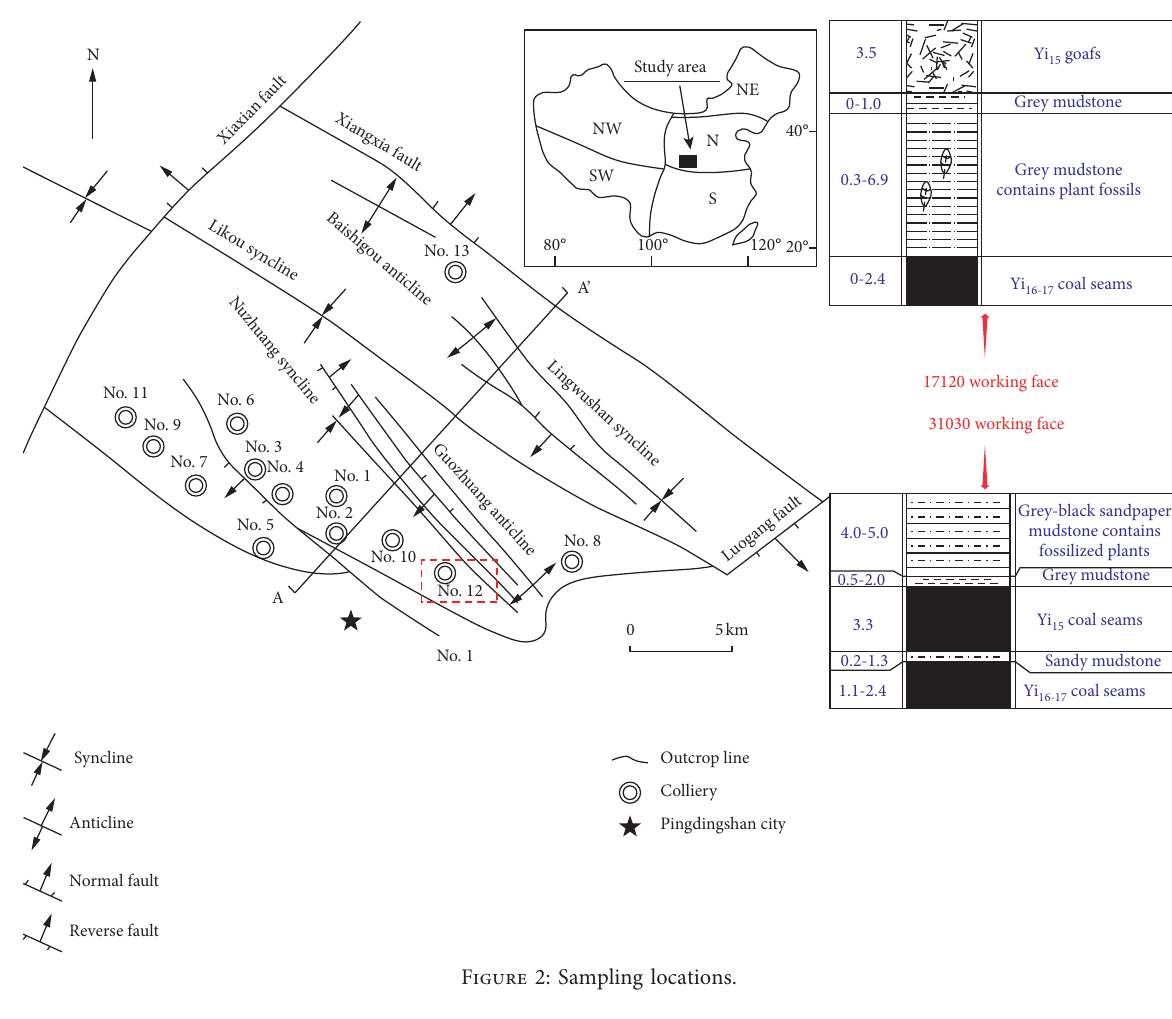
Figure 2: Sampling locations.